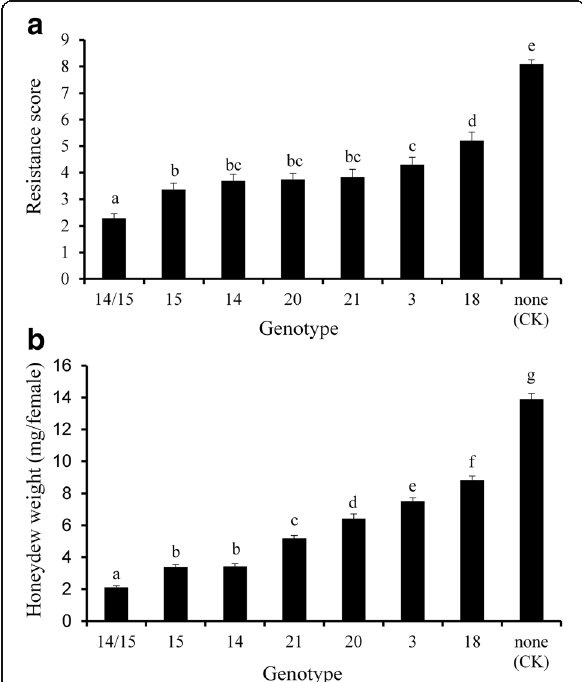
Fig. 3 a The resistance scores of pyramided line and introgression lines of Jin 23B conferring to BPH at seedling stage. The resistance score was determined by the mean of score from at least 30 lines each homogenous allele combination. b The honeydew weight per BPH females on improved lines of Jin 23B. Number 14/15 represent Jin 23B ( Bph14 / Bph15 ), 15 represent Jin 23B ( Bph15 ), 14 represent Jin 23B ( Bph14 ), 20 represent Jin 23B ( Bph20 ), 21 represent Jin 23B ( Bph21 ), 3 represent Jin 23B ( Bph3 ) and 18 represent Jin 23B ( Bph18 ). none (CK): Jin 23B. The different letters above the bars are significantly different at P < 0.05 level